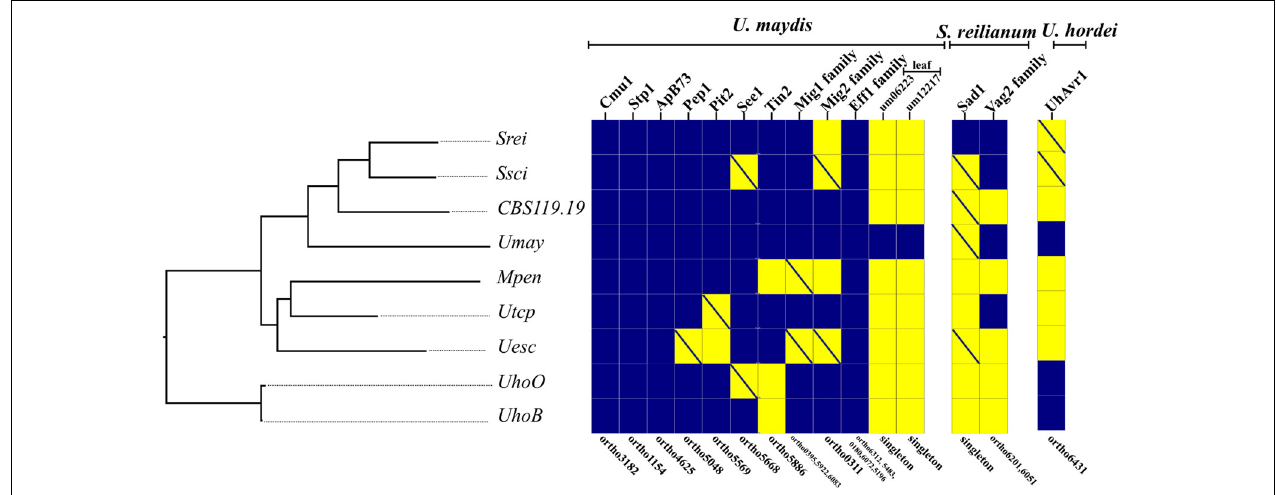
FIGURE 6 | Presence (blue squares) and absence (yellow squares) of genes or gene families encoding known effectors in U. maydis , S. reilianum, and U. hordei based on OrthoMCL groups. The OrthoMCL groups are indicated in the lower part of the figure. Crossed yellow squares indicate that a similar genic region is present in the genome by tblastn search. The species are ordered according to their phylogenetic relationship. The scientific names were abbreviated according to Table 1